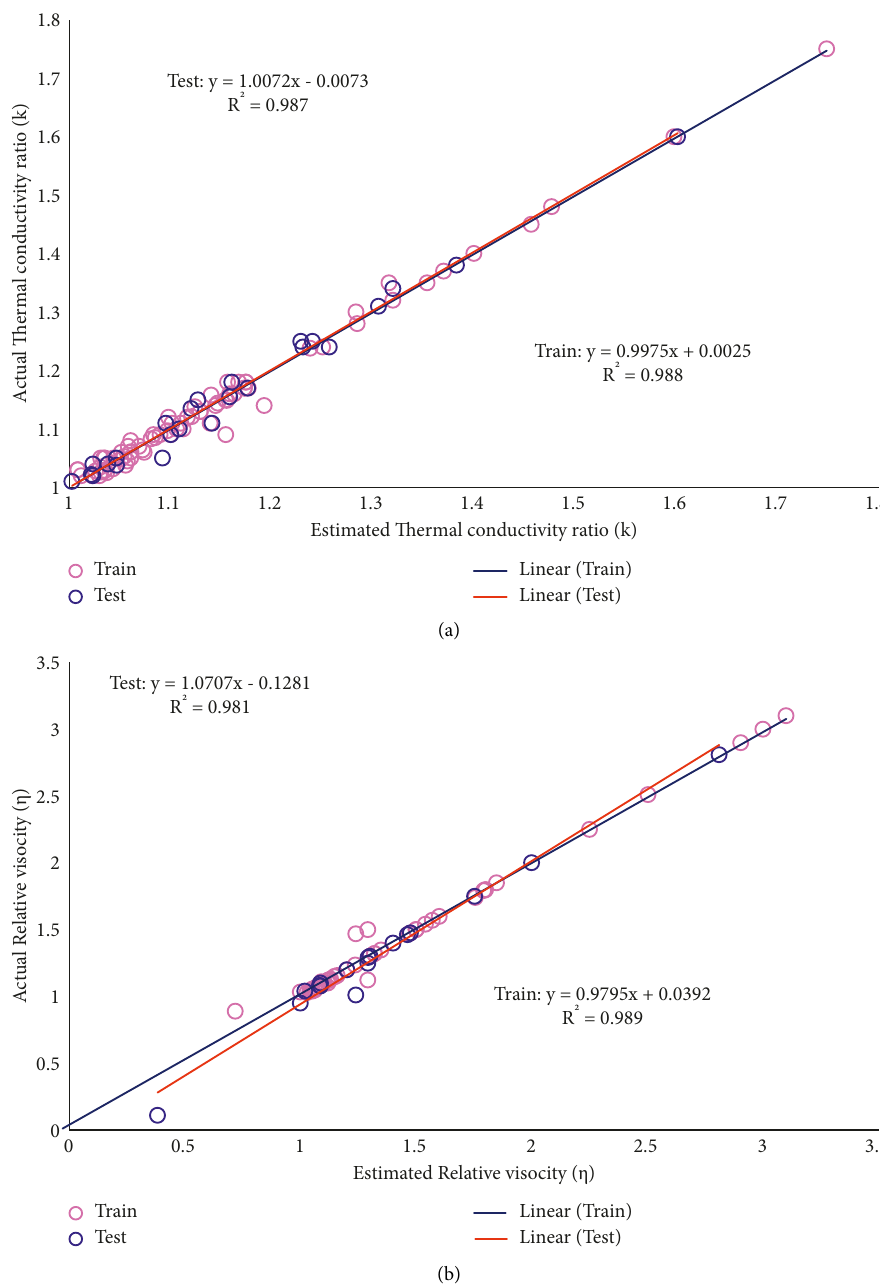
Figure 2: Regression analysis on the (a) TC ratio and (b) relative viscosity of NFs data related to training and testing